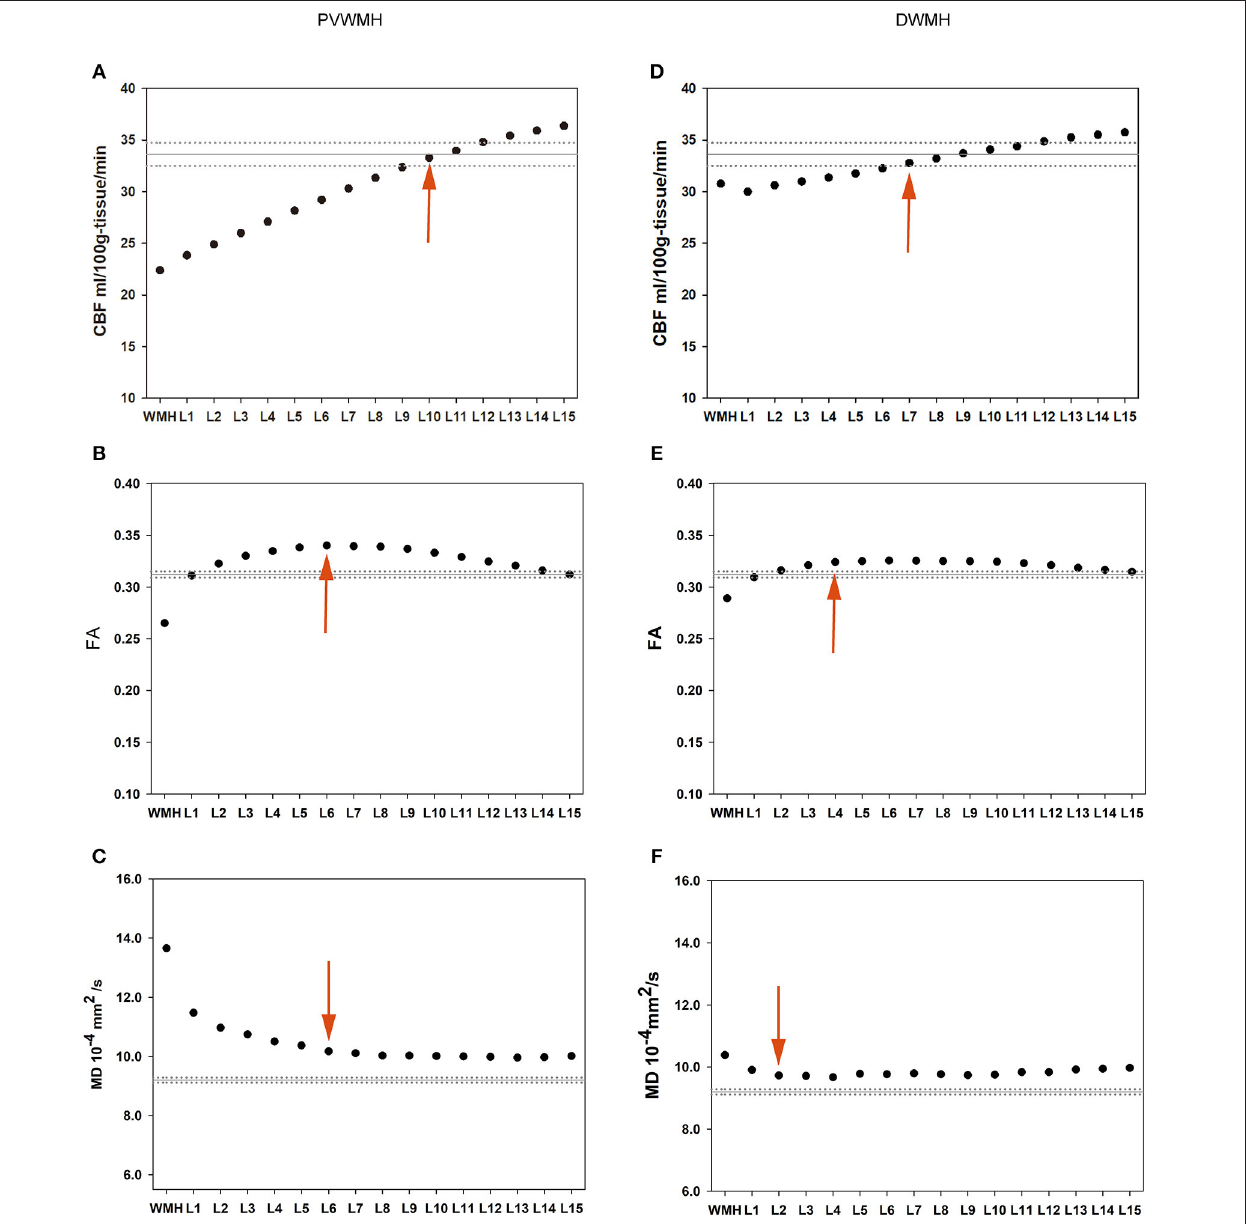
FIGURE 2 | Group means of the PVWMH (the left column) and DWMH (the right column) and their outer NAWM layers. The solid horizontal and dotted lines represent the mean and standard error of the whole-brain NAWM CBF, FA, and MD values, respectively. Red arrows represent the outer boundary of WMH penumbra for each dataset. (A) PVWMH-CBF; (B) PVWMH-FA; (C) PVWMH-MD; (D) DWMH-CBF; (E) DWMH-FA; (F)